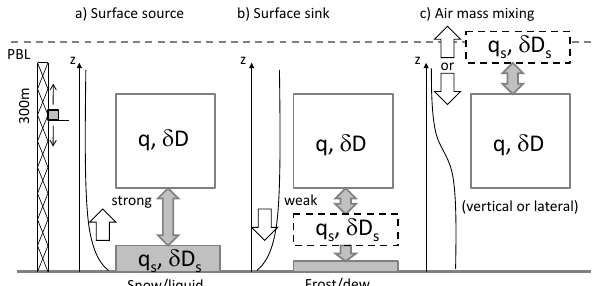
Fig. 1. Schematic depiction of three cases for applying mixing mod- els to water vapor and δ D profile measurements in the case of (a) a surface source with humidity anomalies that propagate upward, (b) a surface sink with humidity anomalies that originate at the bot- tom of the profile, or (c) exchange at the top of the profile. The tower is shown pictorially on the left with the instrument elevator moving either up or down. Curves on the left of each case indicate approximate water vapor or δ D profiles, and boxes depict reservoirs that compose a mass balance. The quantities q and δ D pertain to the measured profiles and q s and δ D s are for the source or sink. Solid arrows show air mass exchange. Open arrows show water ex- changes. The δ D value of these fluxes is sought from a mixing line analysis.